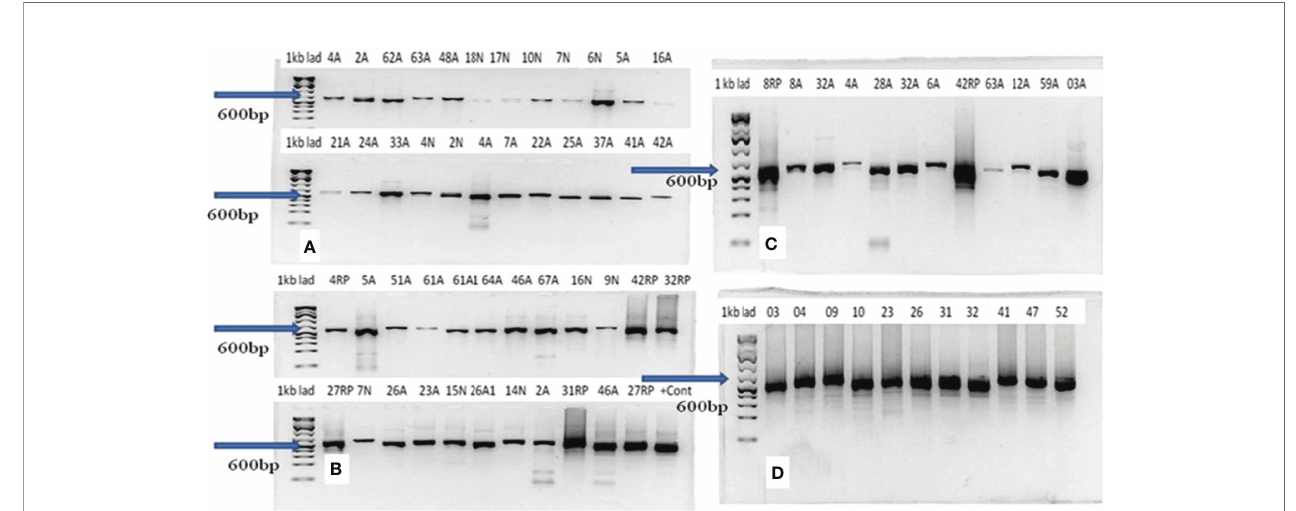
FIGURE 3 | Result of gel electrophoresis of PCR products of Histoplasma capsulatum isolated from epizootic lymphangitis cases of horses in central Ethiopia. In each gel (A – D) , the left lane is the 1-kb ladder while the remaining 12 lanes (2 – 13) represent samples. The molecular weights of all PCR products were equal and were about 600 bp as indicated by arrows on each